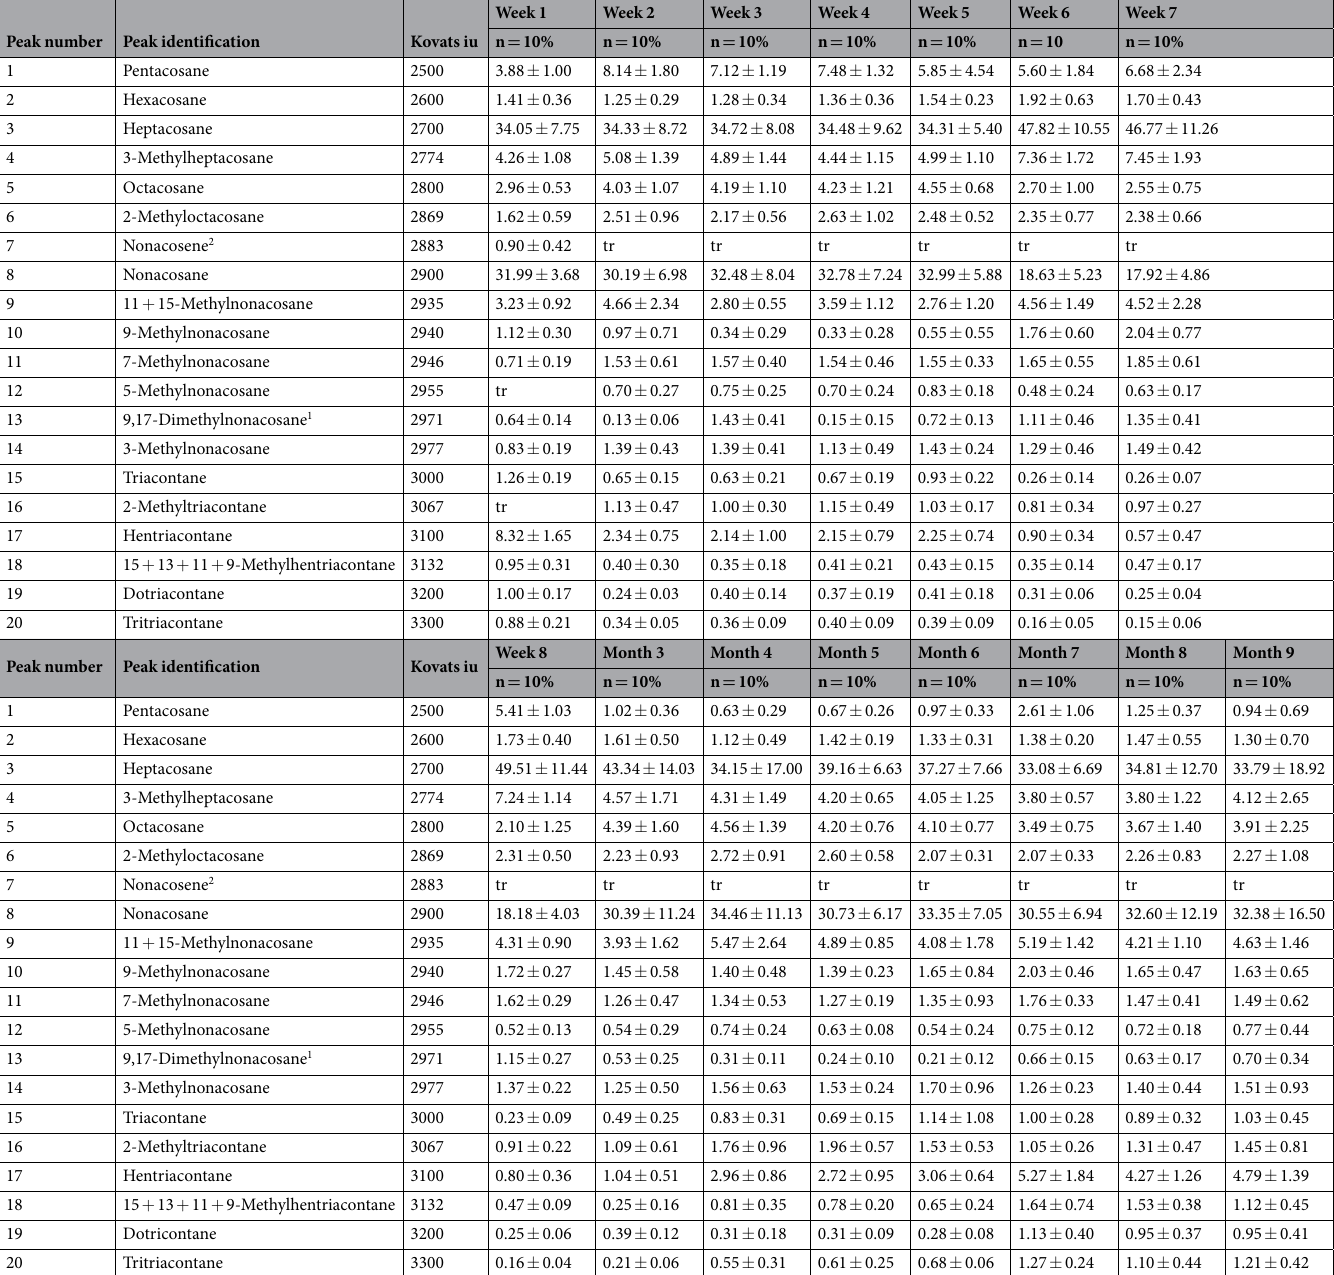
Table 1. List of the compounds extracted from the puparial case and used for subsequent multivariate analysis of L . sericata , with the total percentage of each compound present, the percentage standard deviation for each week/month and the Kovats Indices to aid identification (peak numbers refer to Fig. 1). 1 Tentative identification based on Kovats Index. 2 Double bond position determined but not assigned to specific